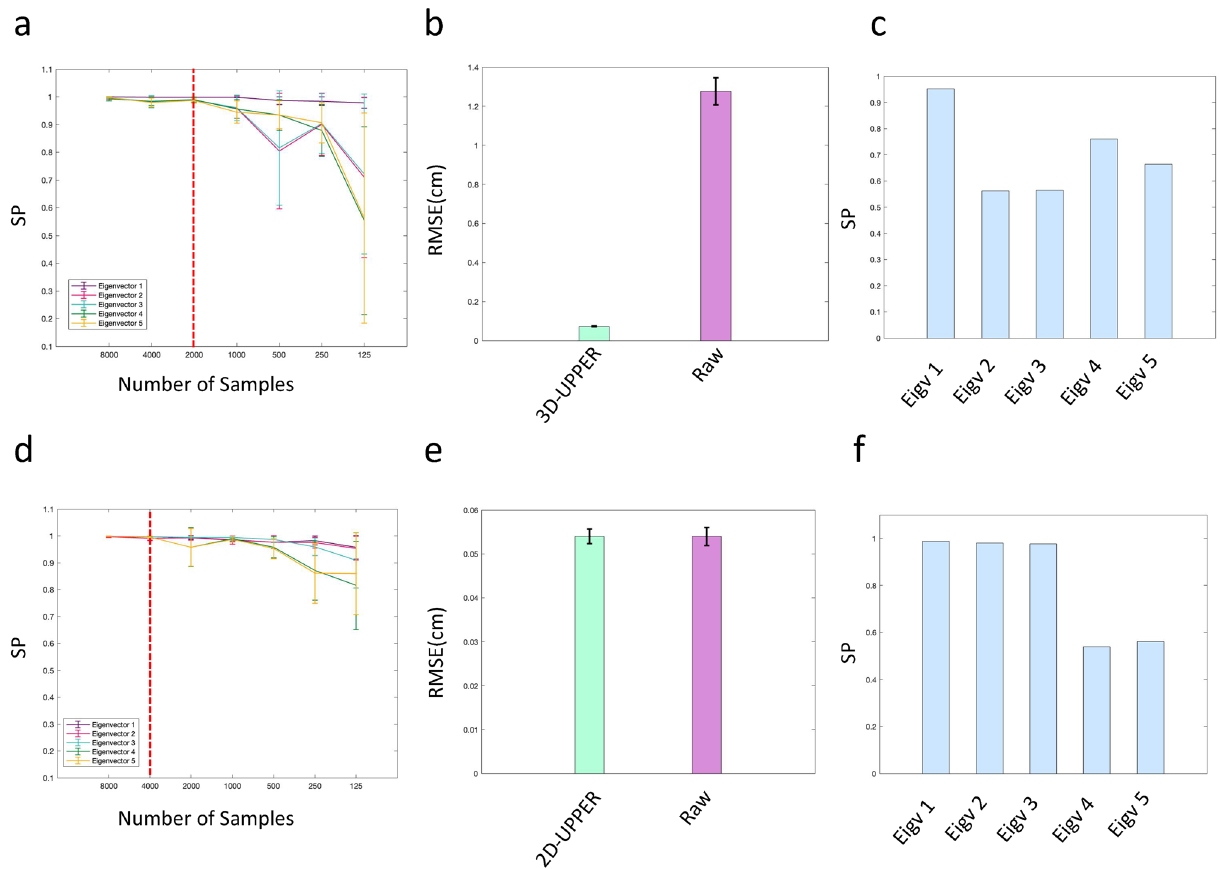
Figure 3. ( a ) Scalar product between eigenposes for independent samples of the dataset. If the eigenposes were the same across samples the scalar product would be equal to one. These results show that eigenposes estimation converges for samples larger than 2000 poses. ( b ) Root-mean-square-error (mean ± SD) between manually labelled data and data reconstructed with 3D-UPPER (green bar). As comparison we show the RMSE between manually labelled data and raw 3D reconstruction obtained by triangulating 2D data (purple bar). The 3D-UPPER algorithm, trained on raw 3D data, achieves a 17-fold reduction in RMSE. ( c ) Scalar product between the first five eigenposes estimated from 100 manually labelled poses with those obtained by using 3D-UPPER. Values inferior to one indicate that estimation of eigenposes based on few manually labelled